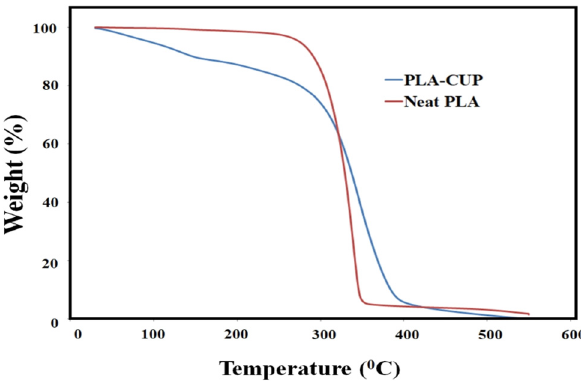
Figure 3: TGA curves of neat PLA and PLA - CUP ( % 15 ) nano fi